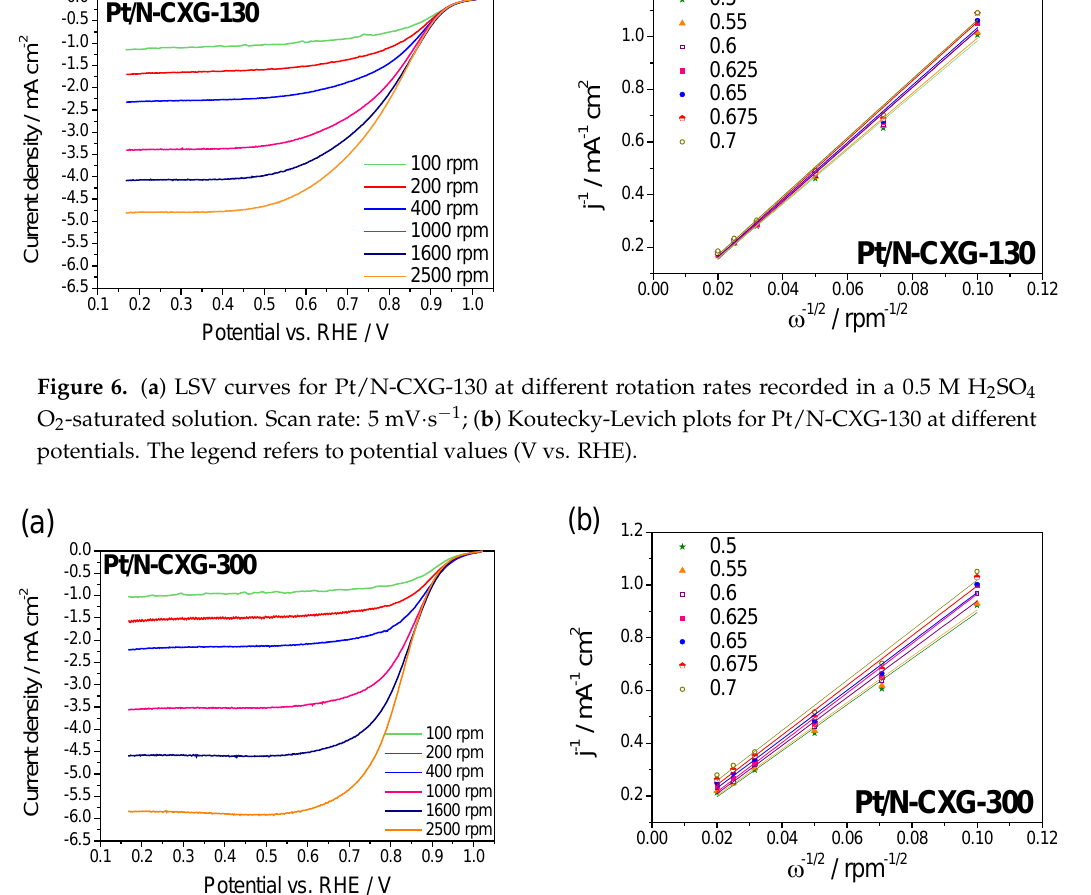
Figure 6. ( a ) LSV curves for Pt/N-CXG-130 at different rotation rates recorded in a 0.5 M H 2 SO 4 O 2 - saturated solution. Scan rate: 5 mV s −1 ; ( b ) Koutecky-Levich plots for Pt/N-CXG-130 at different potentials. The legend refers to potential values (V vs. RHE).